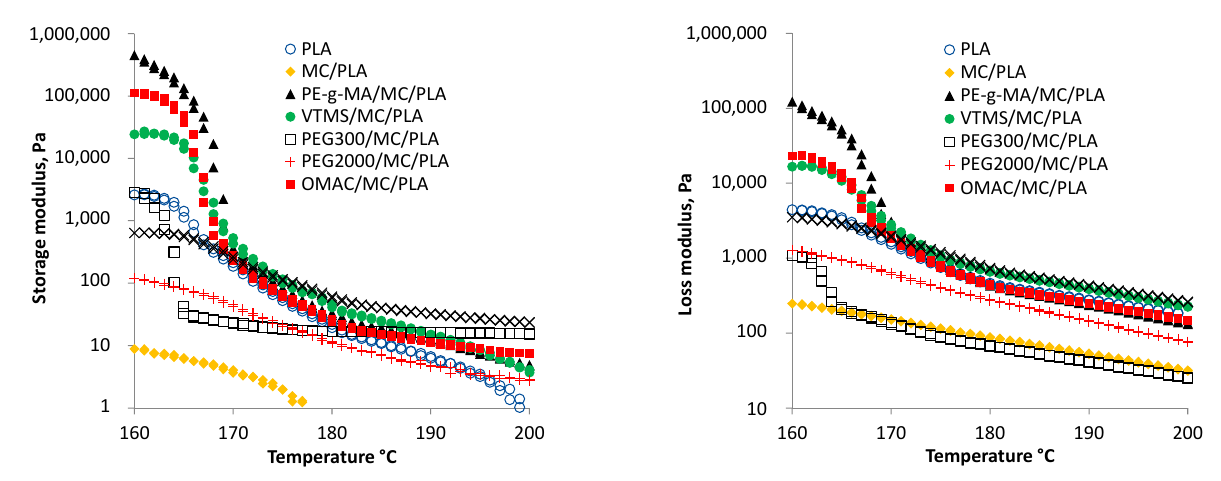
Figure 11. The storage modulus and loss modulus of composite samples.